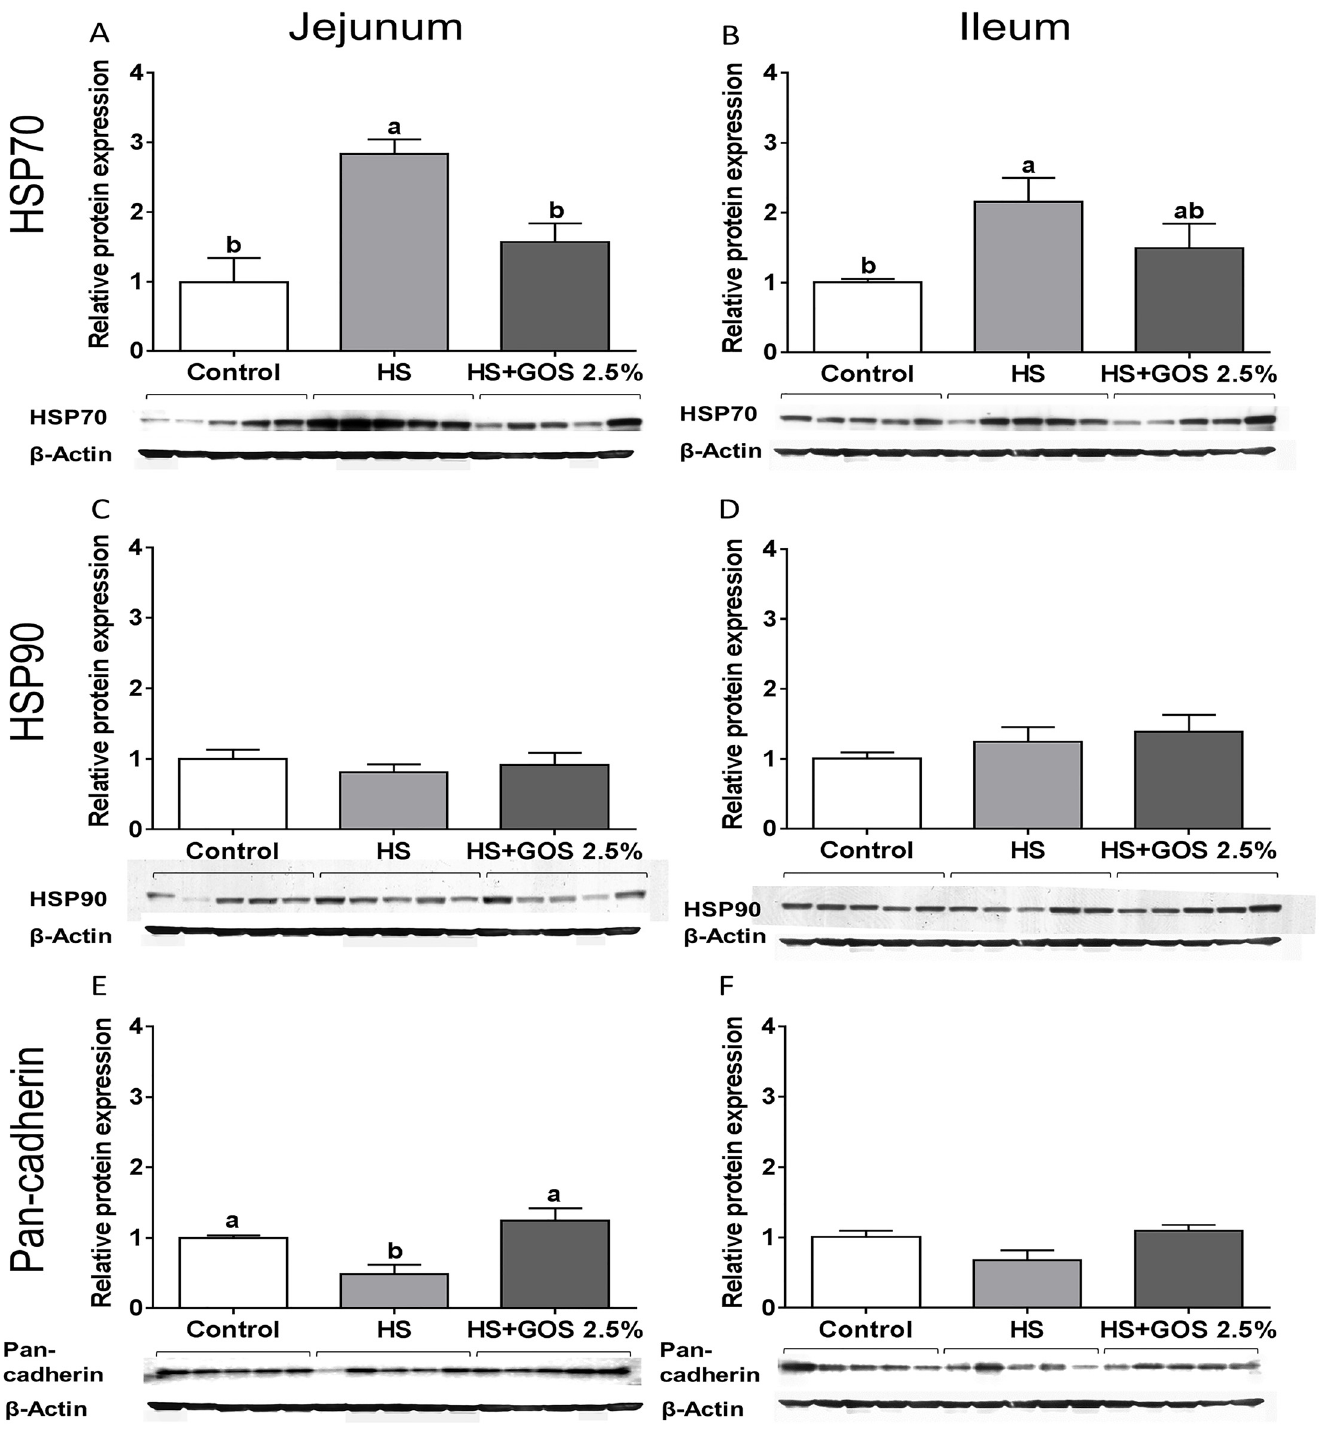
Fig 2. The effect of heat stress exposure on the protein expression of HSPs and pan-cadherin in jejunum and ileum of chickens fed a control or GOS diet. Chickens fed a control or GOS 2.5% diet for 6 days before being exposed to control or heat stress conditions for 5 days. Protein expression levels of HSP70 (A, B), HSP90 (C, D) and pan-cadherin (E, F) were measured in jejunum (A, C, E) and ileum (B, D, F) by western blot analysis (lane 1 – 5: control chickens, lane 6 – 10: heat-exposed chickens, lane 11 – 15: heat-exposed chickens fed a GOS diet). Results are expressed as relative protein expression (fold of control, normalized to β -actin) as mean ± SEM. n = 5 animals/experimental group. Different lower-case letters denote significant differences among groups.